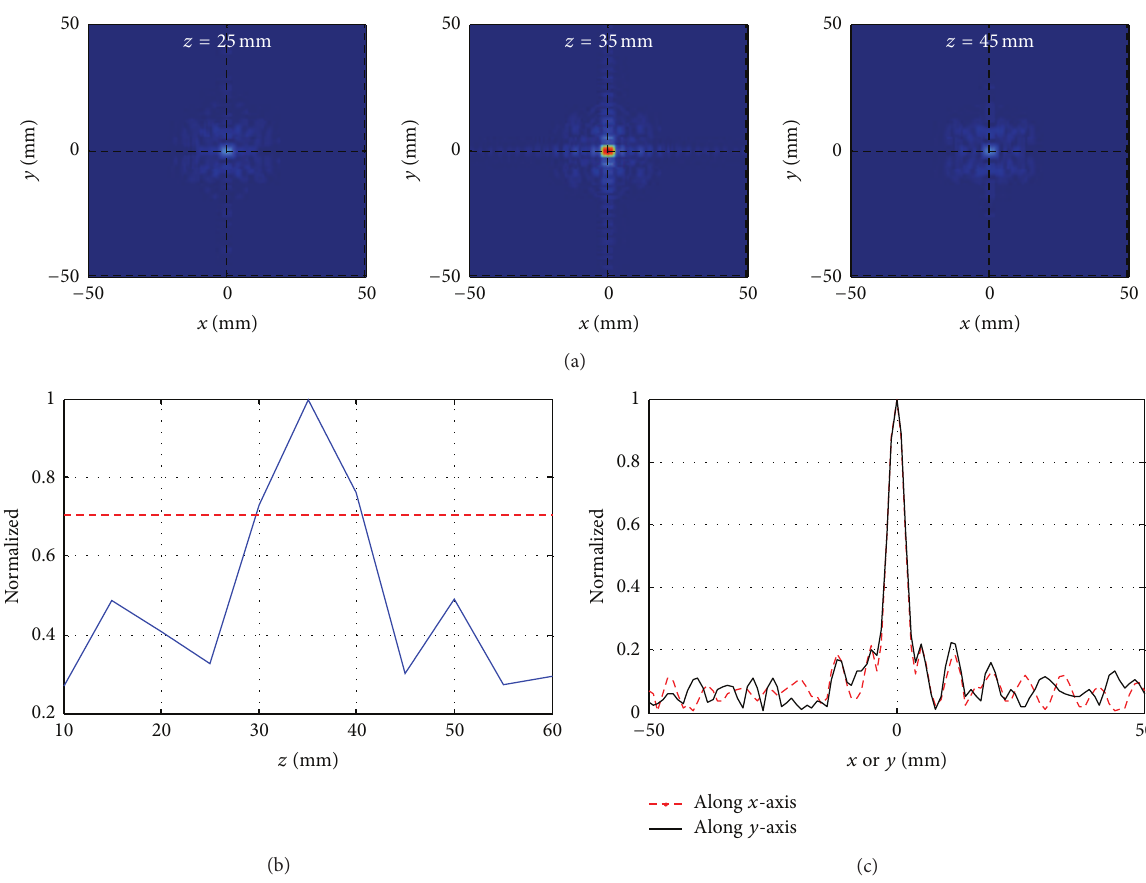
Figure 8: (a) Reconstructed images (shown every 10mm along 𝑧 and only at three range locations) when the distance between the reconstruction planes is Δ𝑧 = 5mm for the example in Figure 6(a). Color bars are the same as in Figure 5. Normalized 1D magnitude of the reconstructed images along (b) range direction ( 𝑧 direction) and (c) cross-range directions ( 𝑥 and 𝑦 directions) in the plane of the object. The red dashed line shows the 3-dB level below the peak (0.7 level on linear